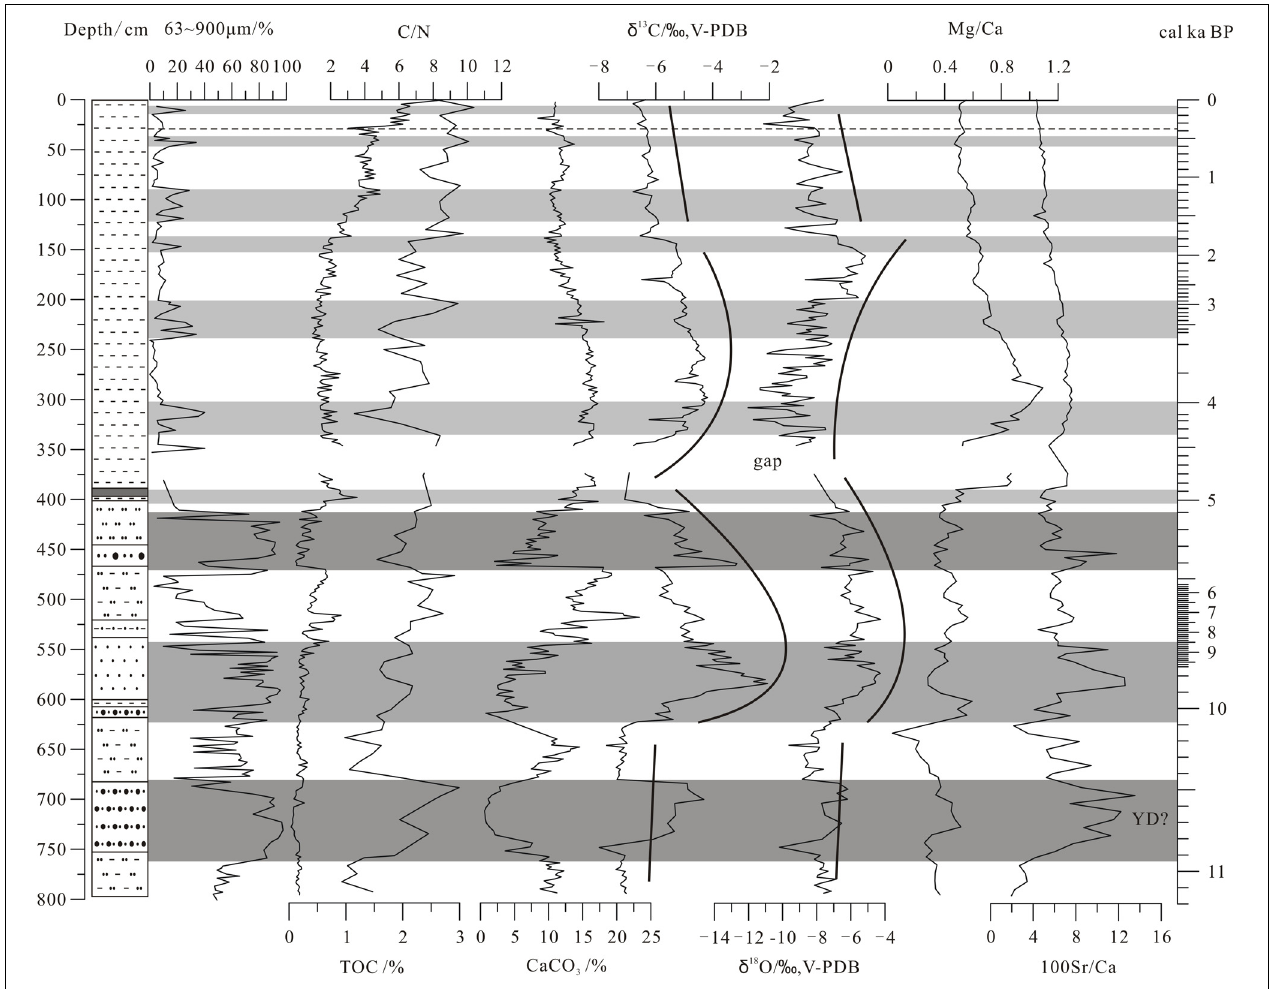
FIGURE 5 | Changes in geochemical proxies in TGN-05 since the last deglaciation. The ratio of Sr/Ca amplifies 100 times to fit for the figure